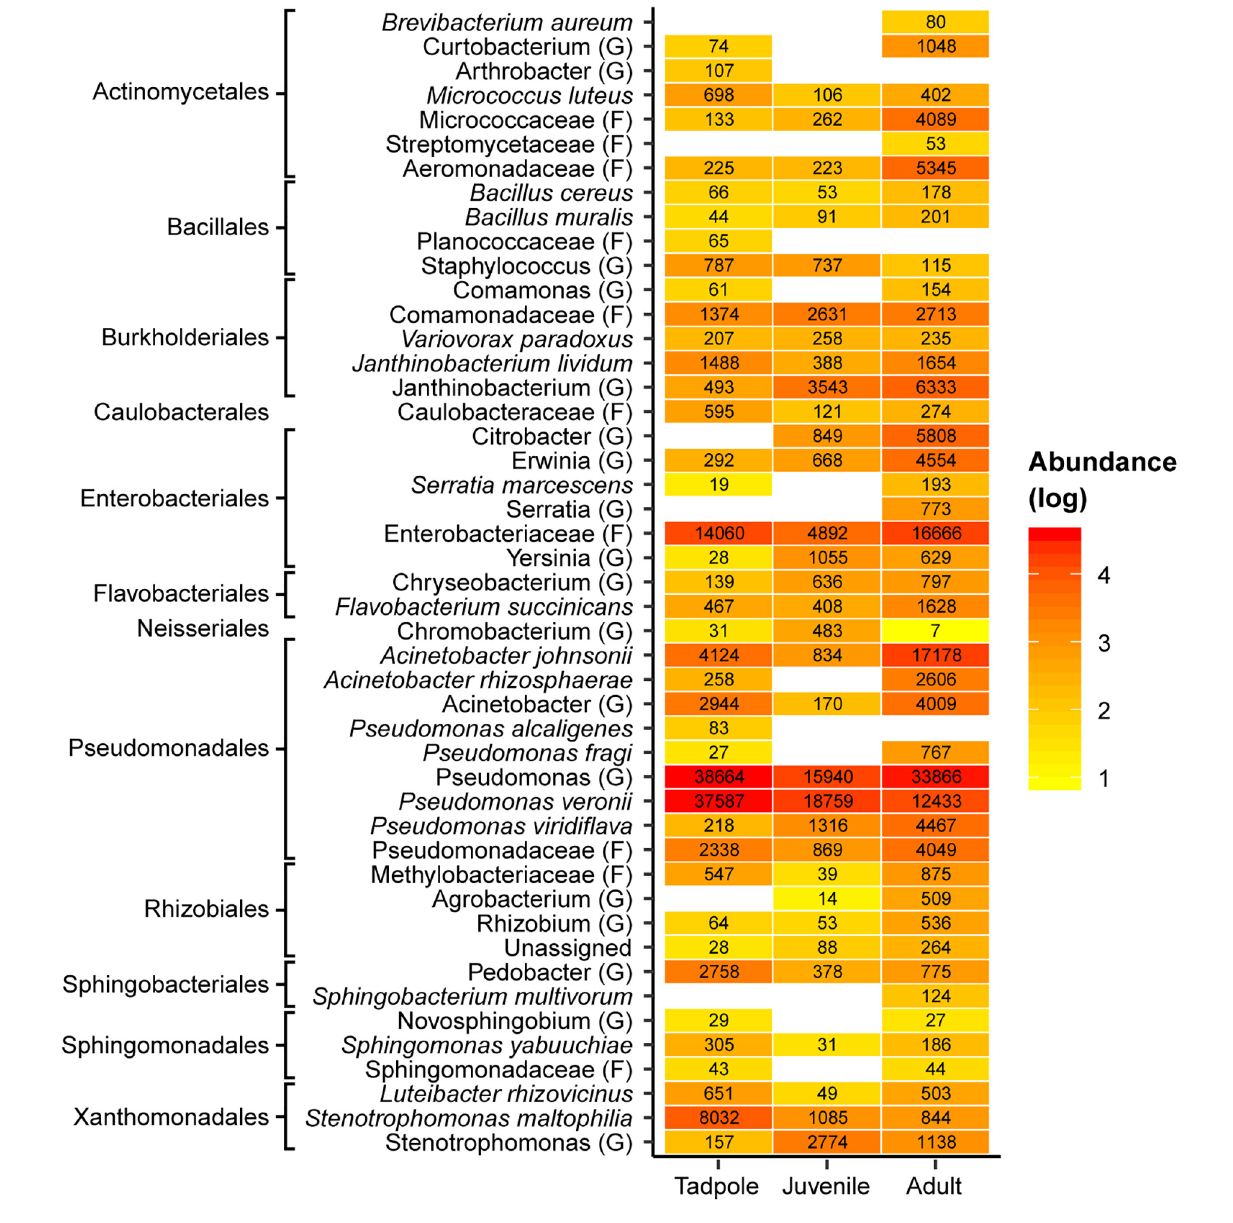
FIGURE 8 | Heatmap of putative Bd -inhibitory ASVs across life stages of L. vibicarius . Reddish colors indicate increasing abundance, yellowish colors indicate lower abundance, whereas white indicates absence of ASVs. The highest possible taxonomic assignment (maximal at the species level) is shown for these ASVs. The numbers indicate the total number of reads of ASVs assigned to specific taxa. G, genus; F,